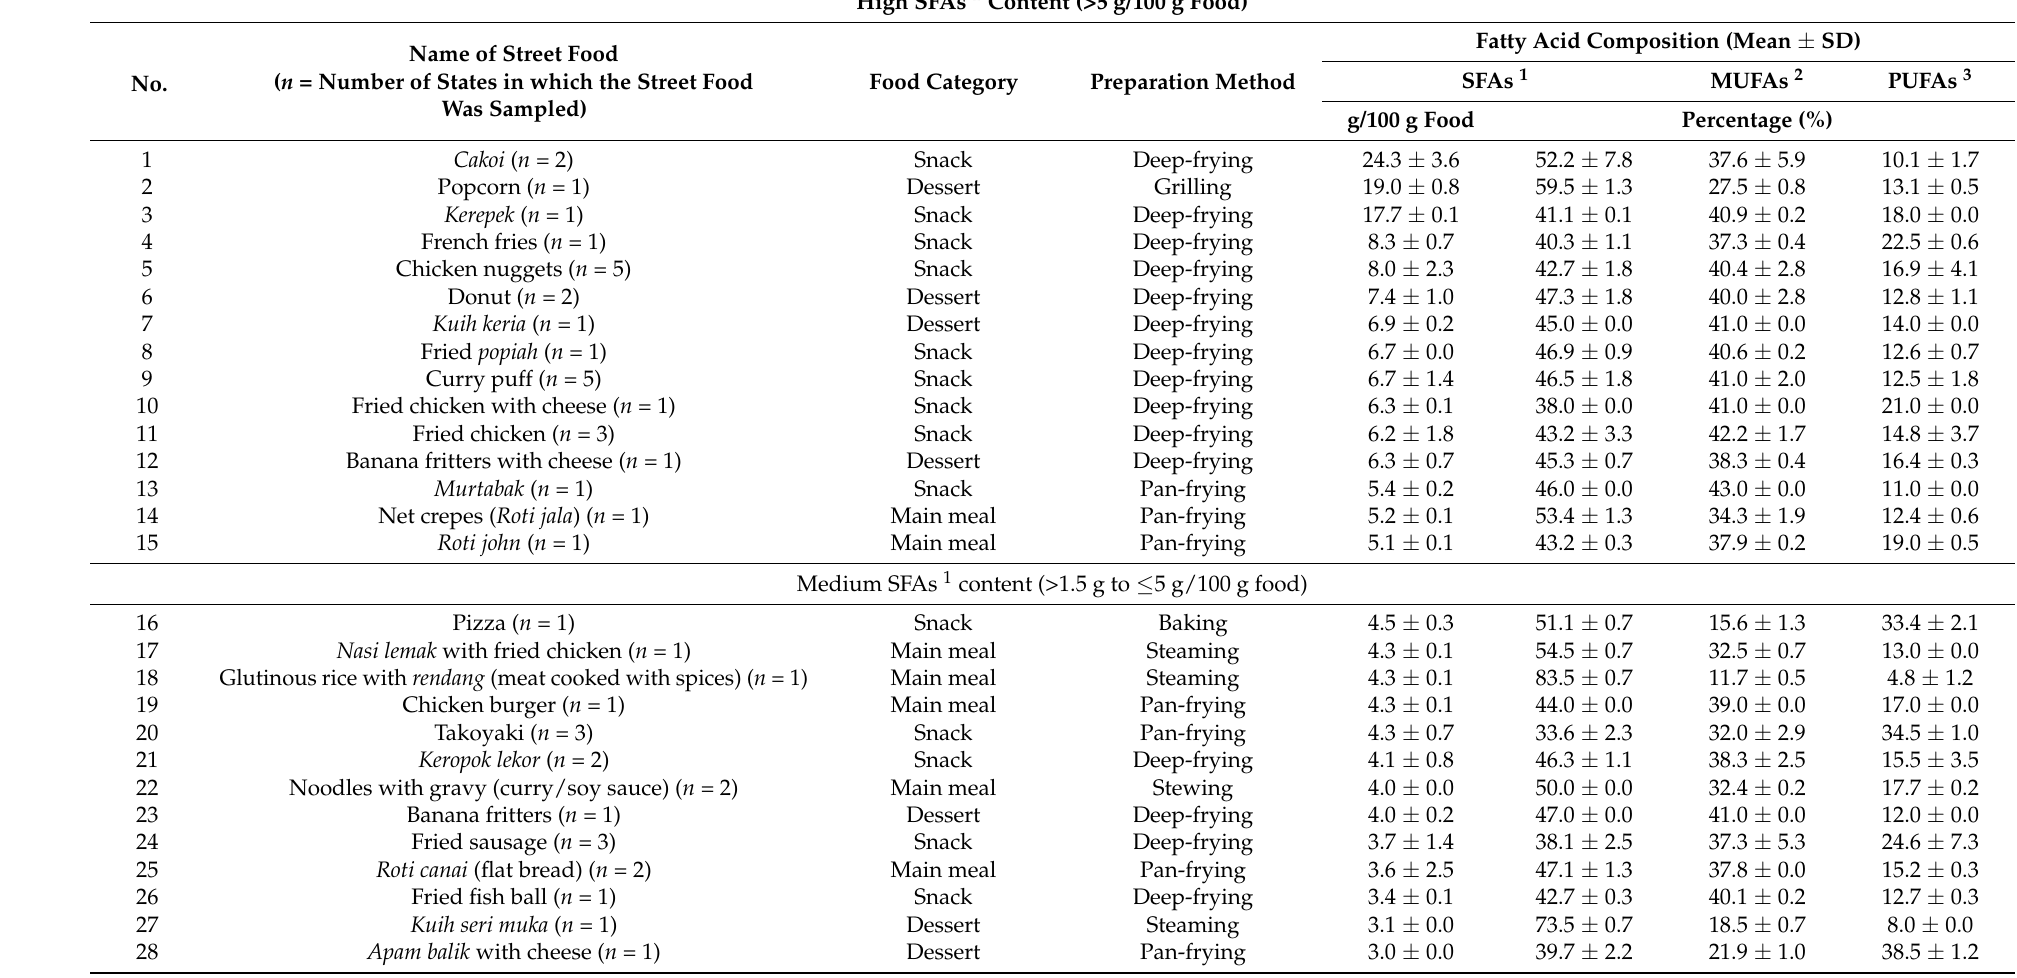
Table 2. Preparation method and fatty acid (FA) composition of 39 street foods according to high (>5 g/100 g food), medium (>1.5 g to ≤ 5 g/100 g food), and low ( ≤ 1.5 g/100 g food) SFAs 1 content classification